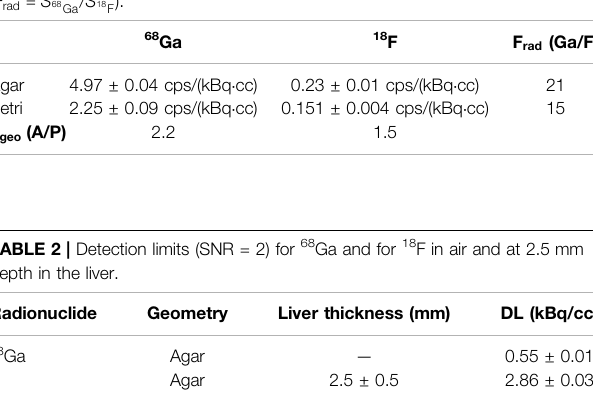
TABLE1| Parameters m ofthelinear fi t S (cid:1) m · c inunitsof[cps/(kBq · cc)],andthe conversion factors for geometry ( F geo (cid:1) S agar / S petri ) and radionuclide